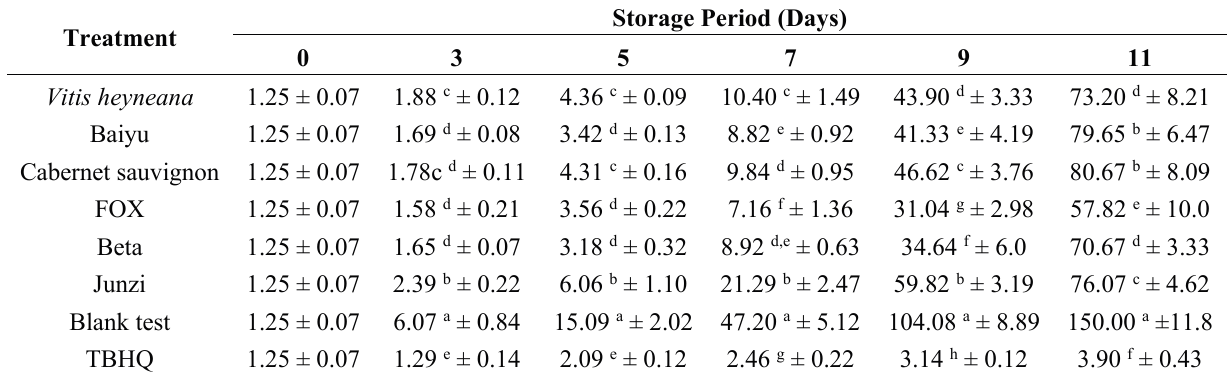
Table 3. POV (meqO 2 /kg sample) of edible oils samples treated with TBHQ and grape polyphenol extracts from canes with chloroform antioxidation test at 70 ± 1 °C, kept in the dark. Treatment